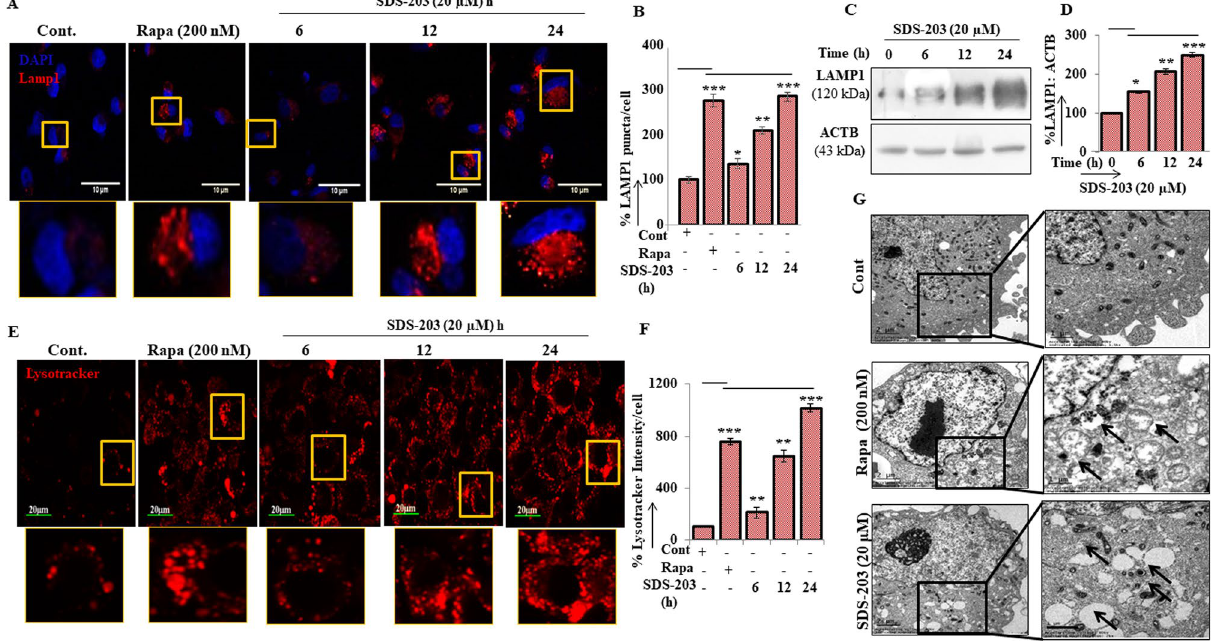
Figure 5. SDS-203 induces lysosomal biogenesis in MIA PaCa-2 cells. ( A , B ) Represent confocal images and puncta density of LAMP1expression upon treatment of SDS-203 (20 µM) for 6, 12, 24 h or rapamycin (200 nM) for 12 h. ( C , D ) Demonstrates LAMP1 protein expression (Western botting) and quantification in MIA PaCa-2 cells incubated with SDS-203 (20 µM) for different time points. ( E , F ) Demonstrate respective lysotracker DND- 99 probe (50 nM) staining and quantification of fluorescent signal in MIA PaCa-2 cell treated with SDS-203 (20 µM) for different time points. ( G ) Represents the accumulation of unfused autophagosomes and lysosomes in pancreatic cancer cells upon SDS-203 treatment versus autolysosomes formation in rapamycin-treated samples, visualized under electron microscopy. Statistics, Student’s t test * p < 0.05, ** p < 0.01, *** p < 0.001 vs. control